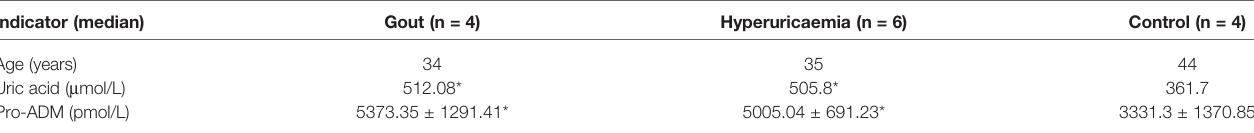
TABLE 2 | Comparison of datas of patients in three groups (*P < 0.05 vs. control). Indicator